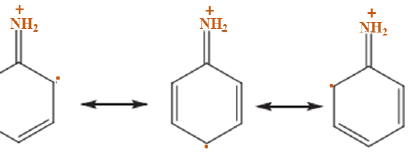
Figure 7. Aniline radical cation in the resonating form. Reproduced with permission from Materials Chemistry and Physics, Vol 69, Koval, E.P.; Whittingham, S.; Skolozdra, O.M.; Zavalij, P.Y.; Zavaliy, I.Y.; Reshetnyak, O.V; Seledets, M. Co-polymers of aniline and nitroanilines. Part I. Mechanism of aniline oxidation polycondensation. , pp. 154 – 162., Copyright (2001), with permission from Elsevier.